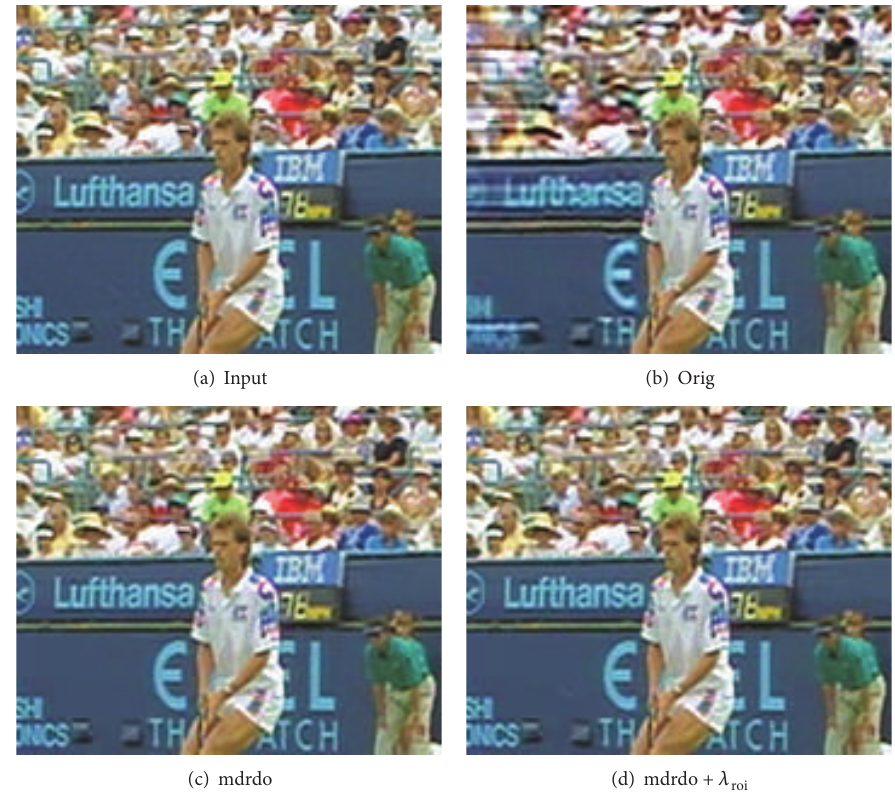
Figure 13: Visual quality comparison under “Dec ROI” scenario for the “stefan”